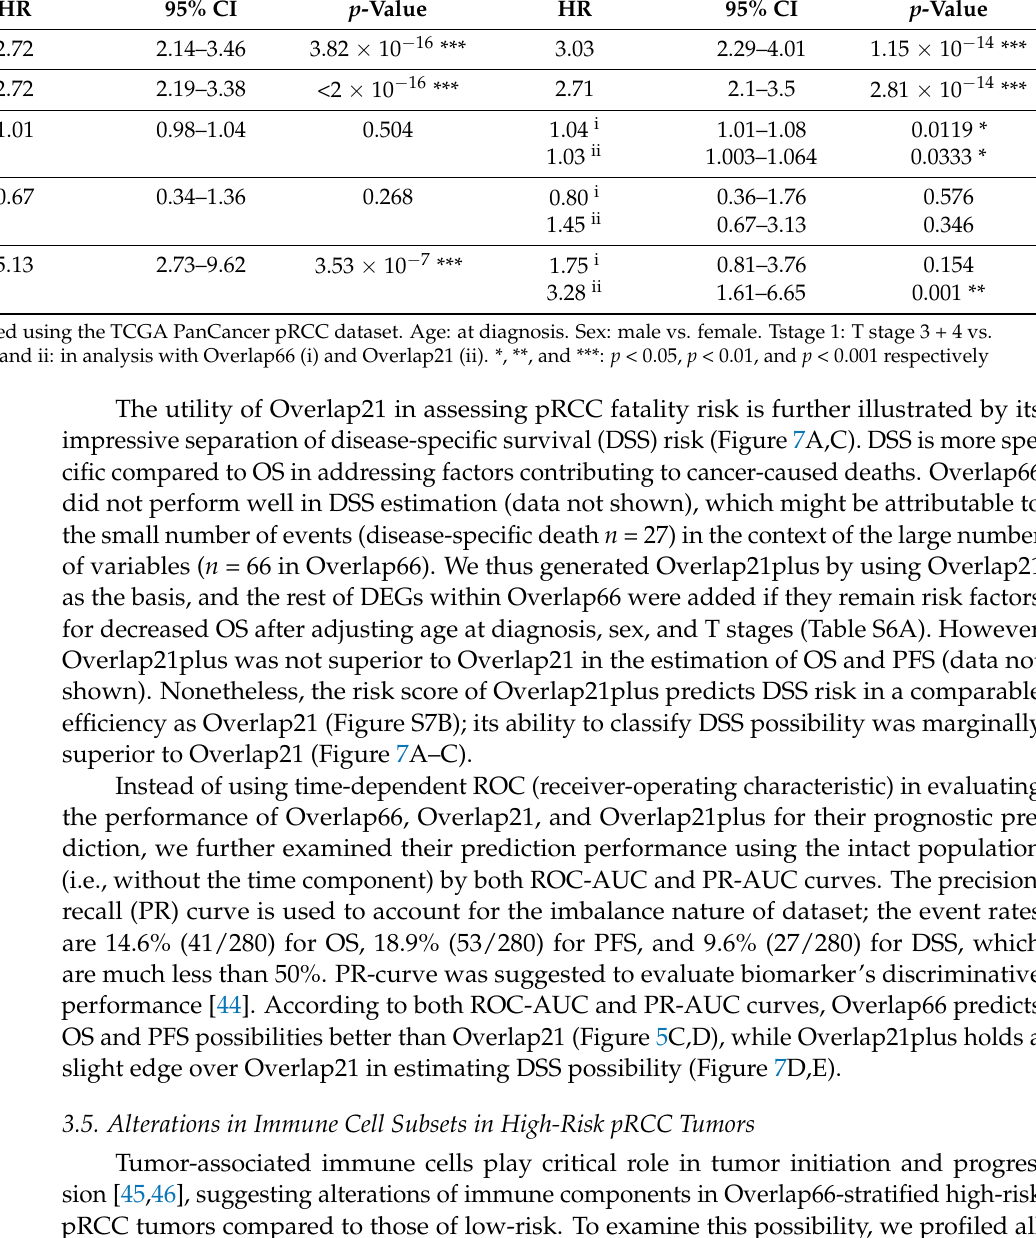
Table 3. Univariate and multivariate Cox analysis of Overlap66 and Overlap21 risk scores for pRCC OS. Univariate Cox Analysis Multivariate Cox Factors